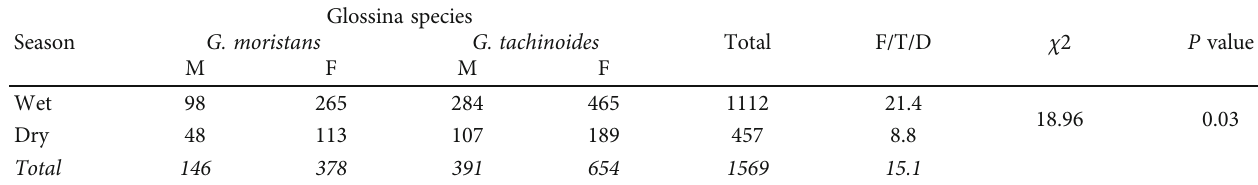
Table 7: The seasonal apparent density of Glossina species in study